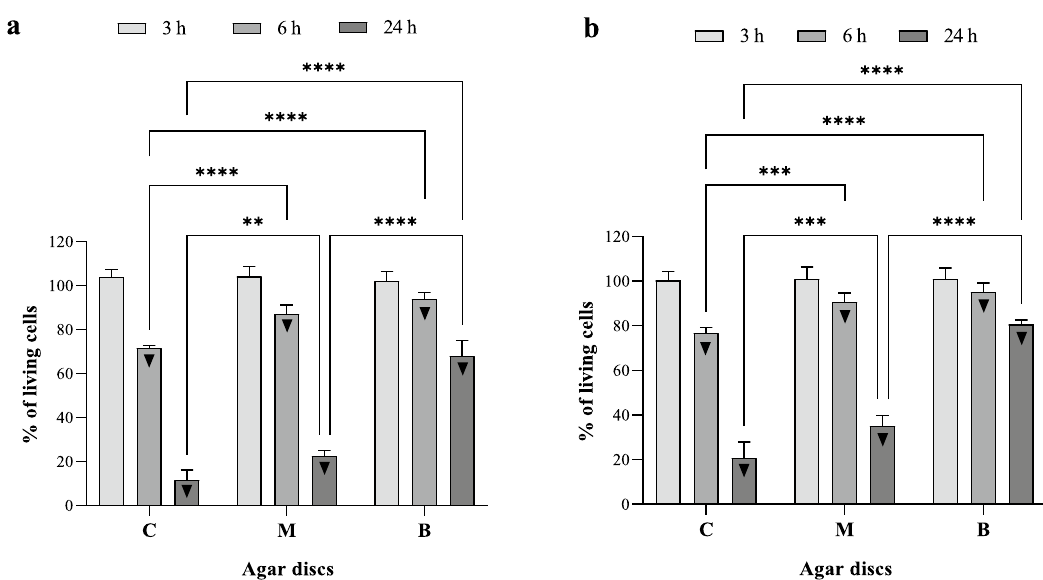
Figure 4. Percent of living ( a ) S. aureus and ( b ) P. aeruginosa biofilm-forming cells on successive agar discs incubated with OCT-saturated carriers. The results are presented as % reduction of living biofilm-forming cells on successive agar discs incubated with OCT-saturated carriers in comparison to the control setting with the carriers soaked with PBS instead of OCT and expressed as a mean ± SEM. The asterisks in the graphs indicate statistically significant differences between OCT-treated biofilms on successive agar discs (* p < 0.05, ** p < 0.01, *** p < 0.001, **** p < 0.0001). ▼ —statistically significant differences ( p < 0.05) between OCT-treated and PBS- treated